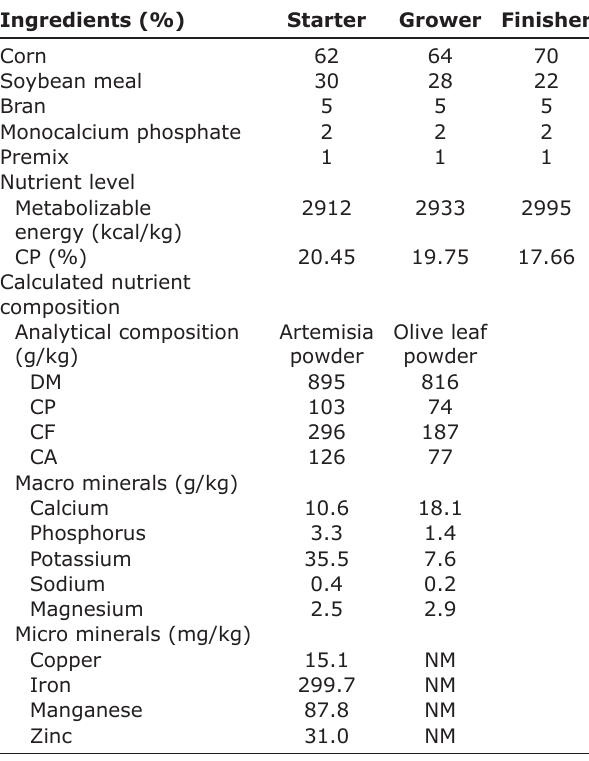
Table-1: Dietary ingredients of SCD for starter, grower, and finisher period and nutrient composition of Artemisia or olive leaf